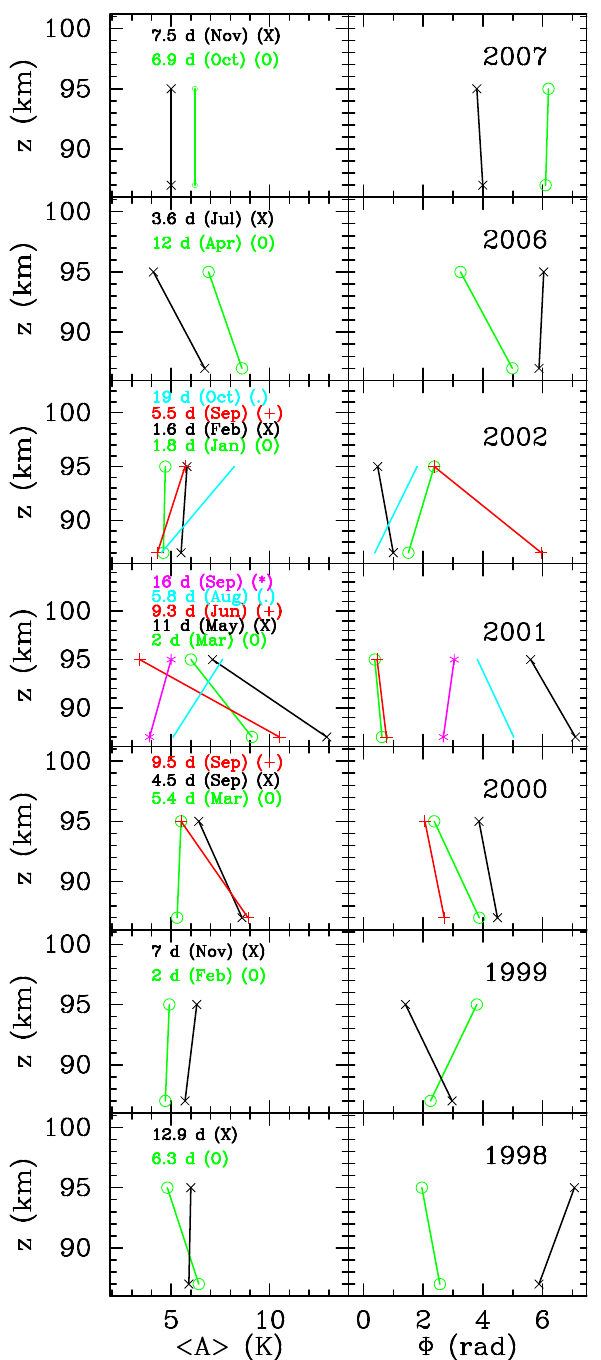
Fig. 6. Amplitudes and phases of the oscillation detected in the temperature oscillations as function of the altitude.